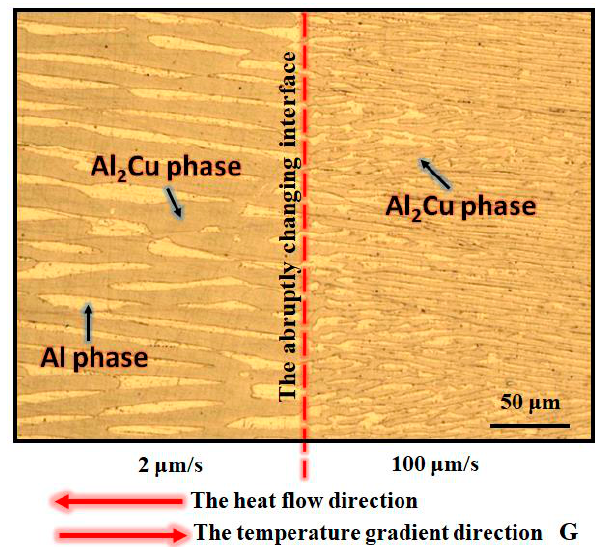
Figure 1. Longitudinal microstructures of the Al-Al 2 Cu eutectic alloy at the abrupt change in pulling rate from 2 μ m/s to 100 μ